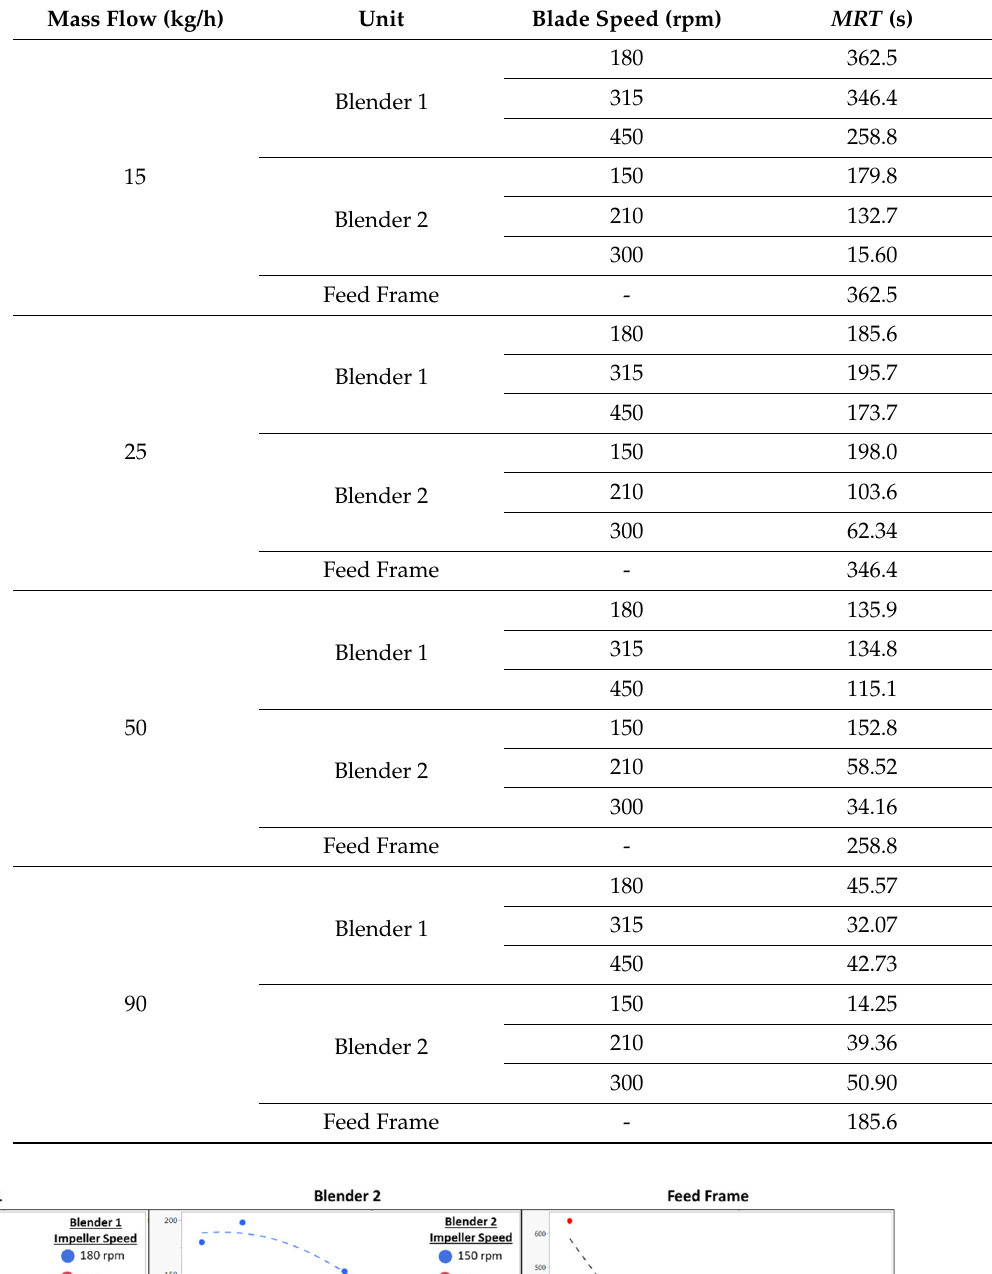
Table 1. Calculated MRT Using Equation (2) for Blender 1, Blender 2, and Feed Frame.